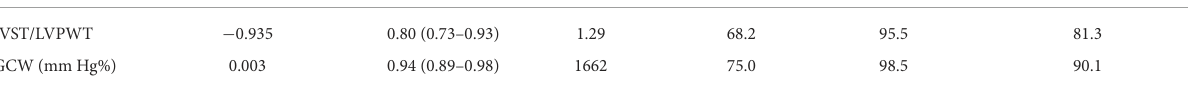
TABLE 4 Multivariate discriminant analysis and ROC curve analysis for distinguishing HCM from H-LVH. Variable